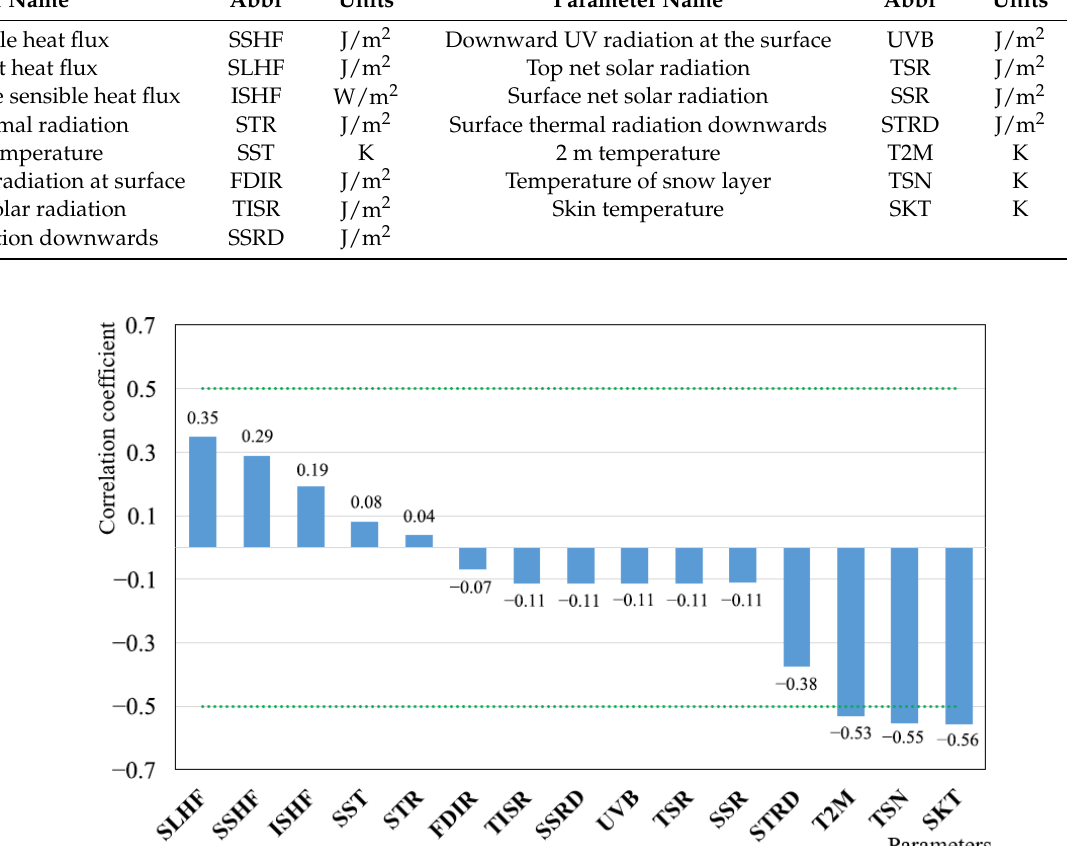
Table 2. List of candidate parameters.